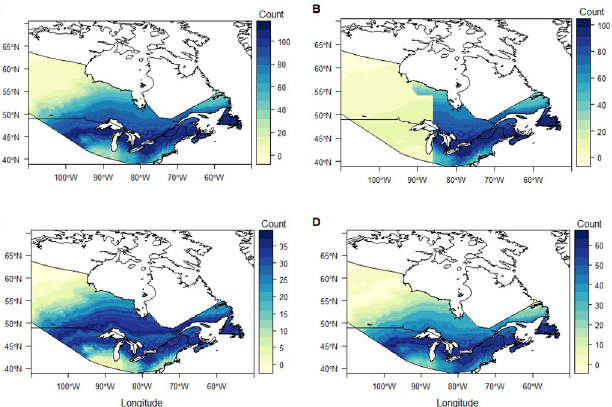
Fig 3. Geographic depiction of probable origins of hatch-year mallards harvested in Ottawa and Sandusky counties, Ohio, USA, from October to December 2019. Legend numbers correspond to the number of individuals assigned to each pixel based on a 2:1 odds ratio. A) all samples in our study without application of a banding data informed weighted spatial mask, B) origins constrained by a banding data informed weighted spatial mask, C) Origins of pure wild mallards without application of a banding data informed weighted spatial mask, and D) Origins of hybrid- swarm mallards without application of a banding data informed weighted spatial mask. U.S. and Canadian political boundaries were obtained through the R package ‘rnaturalearth’. Atlantic and Mississippi flyway shapefiles were obtained from the metadata of Weltzin et al. 2018 (https://www.sciencebase.gov/catalog/item/ 5b75d10ee4b0f5d5787fea6f). Atlantic and Mississippi flyway boundaries and data were used from Weltzin et al. 2018 (https://www.sciencebase.gov/catalog/item/5b75d10ee4b0f5d5787fea6f). The calibration equation used to produce the assignment to origin was obtained from van Dijk et al. 2014. Except for the shapefiles listed above, no external data was used for the creation of the figure. Figures were created using the R statistical framework (version 4.0.2, R Core Team